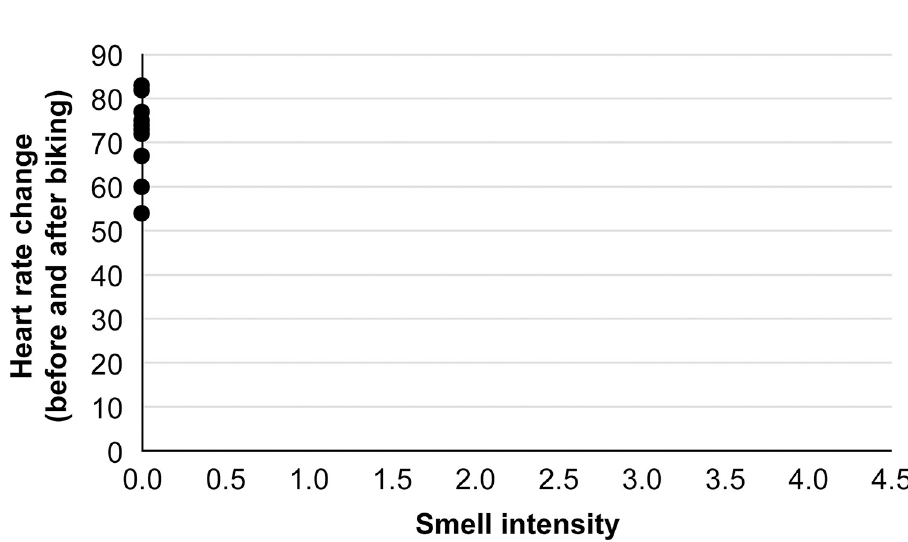
Fig 6. Relationship between the intensity of tension-stress odor during exercise and changes in heart rate. A panel of four scent experts evaluated the collected skin-gas samples to identify odor differences among individuals exercising and at rest. No characteristic odor resembling stir-fried leek was observed in any samples when the heart rate increased because of exercise.